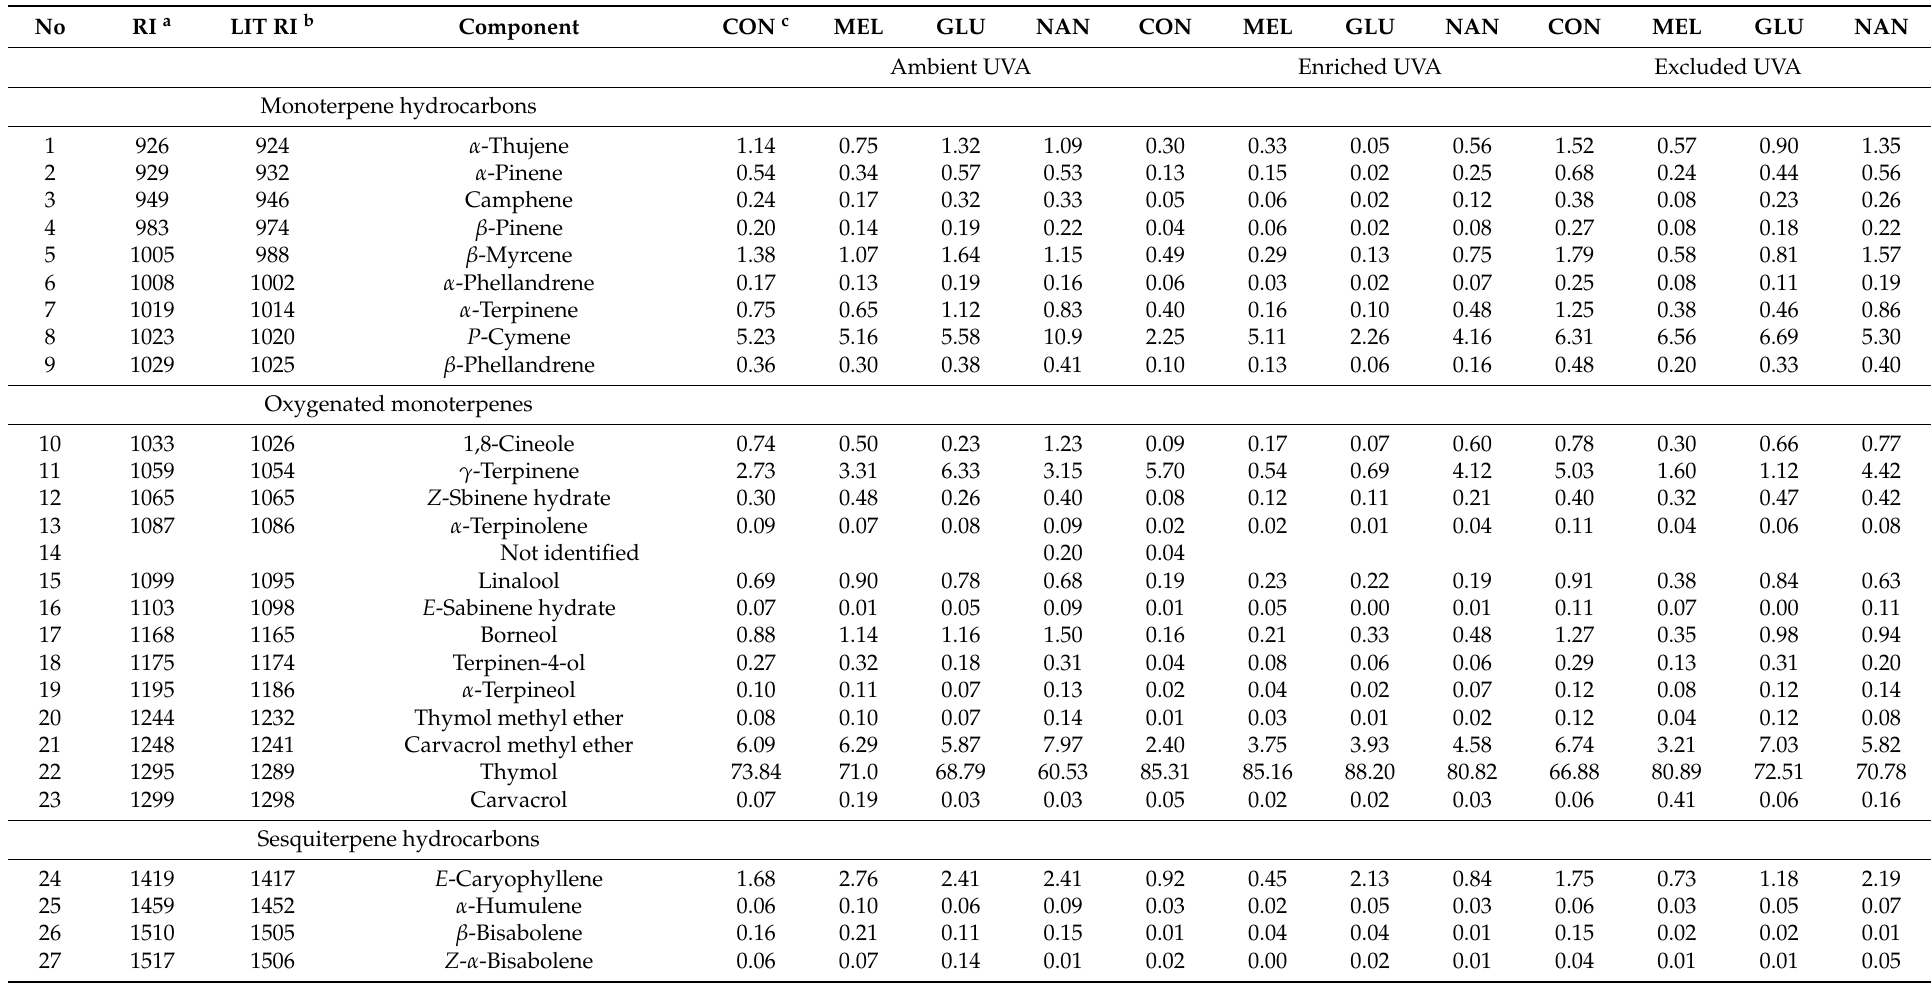
Table 3. The essential oil profile of Thymus daenensis under different UVA levels (ambient, enriched, excluded) in combination with spraying protectants